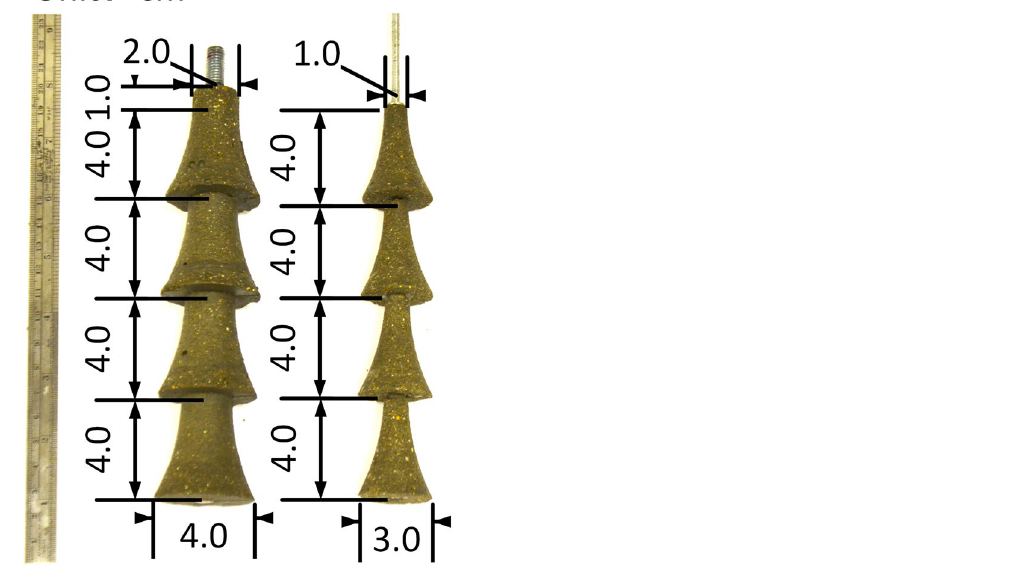
Figure 2. Multibell anchors for